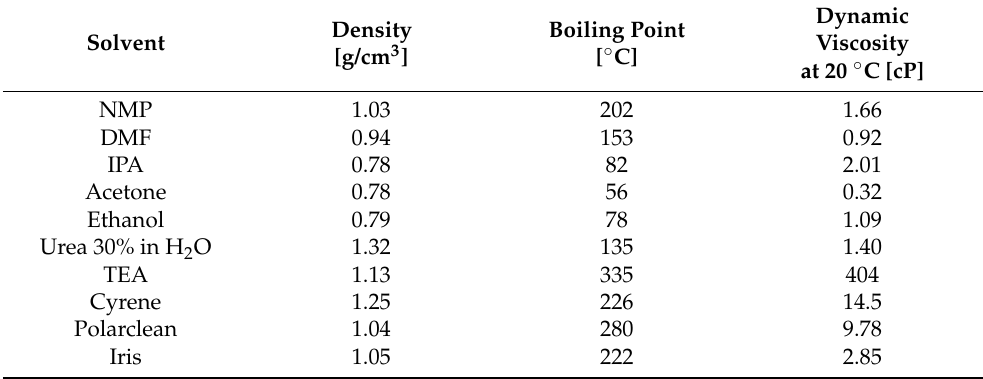
Table 3. Density, boiling point, and dynamic viscosity at 25 ◦ C for NMP, DMF, IPA, acetone, ethanol, aqueous urea solutions, Cyrene, Polarclean, and